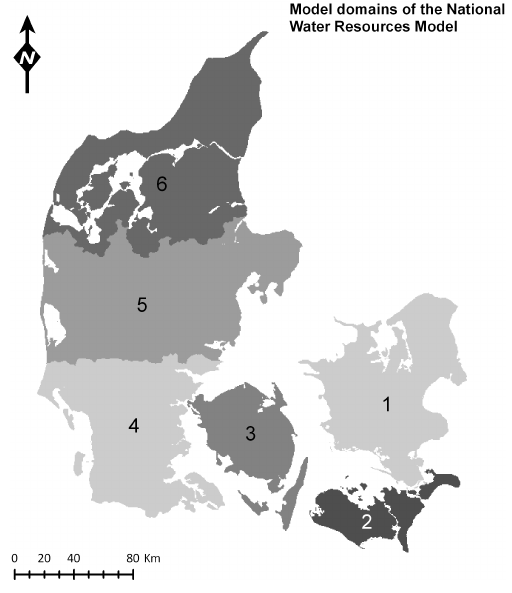
Fig. 2. Six model domains of the Danish national water resources model.